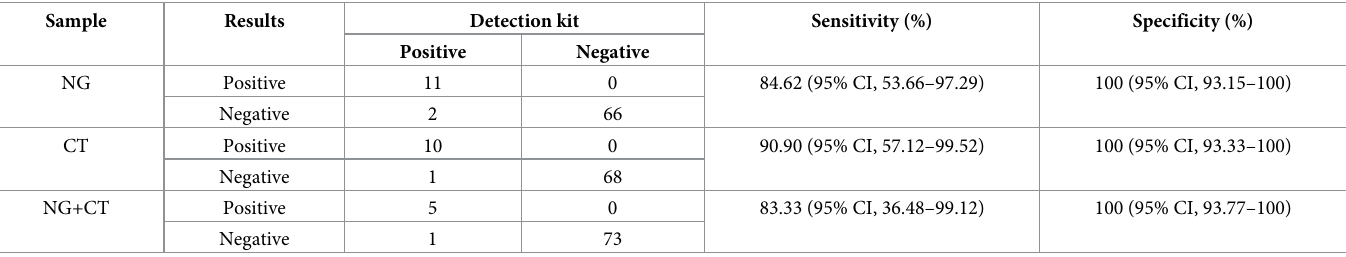
Table 2. Sensitivity and specificity of multiple RPA-LFD assay.